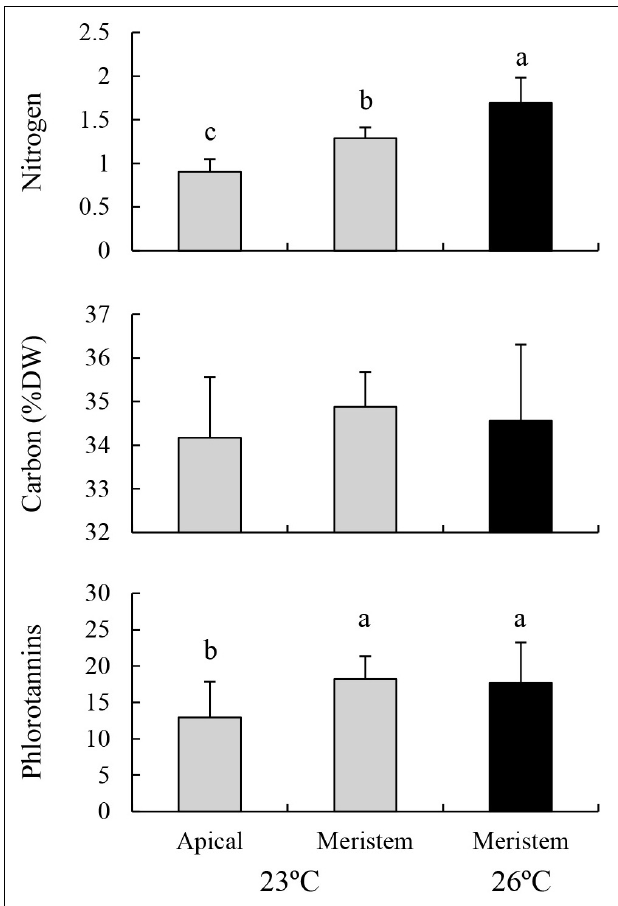
FIGURE 4 | Nitrogen, carbon, and phlorotannin contents of the apical part and meristems (i.e., lower part) of the blades of E. bicyclis juvenile sporophytes cultured at 23 ◦ C, and of erose blades (i.e., meristem only) cultured at 26 ◦ C (mean ± SD, n = 8). Different small letters indicate significant differences among different